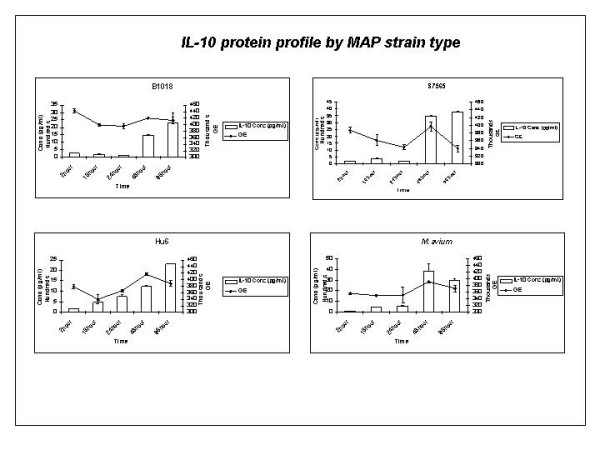
IL-10 protein secreted by MDM cells exposed to MAP over time was measured by ELISA. Total amount of protein (pg/ml) is plotted on Y-axis (note that the Y1-axis scales have been optimized for magnitude of IL-10 expression for each strain). Intracellular bacterial numbers were calculated based on genome size of MAP and represented as genome equivalents (GE) on second Y-axis. MDMs stimulated with B1018 and Hu6 MAP isolates gradually up regulated IL-10 secretion from 2-hr until 96-hr PI.